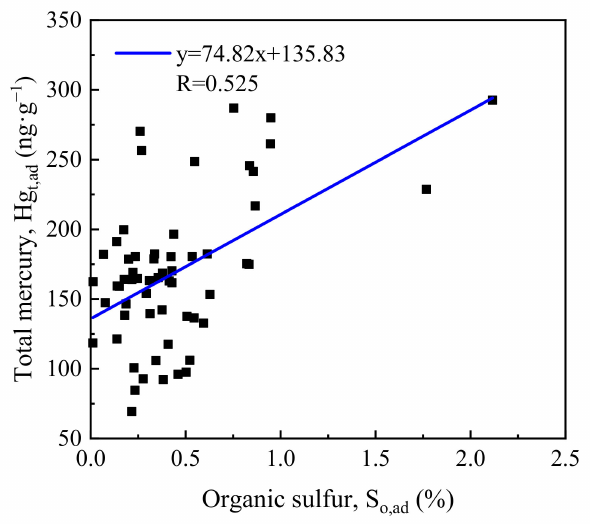
Figure 6. Correlation between Hg and organic sulfur in 59 coal samples.